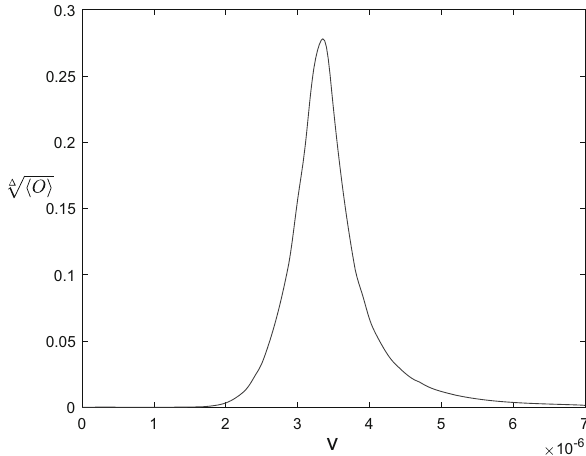
(cid:6) (cid:7) O (cid:8) p r